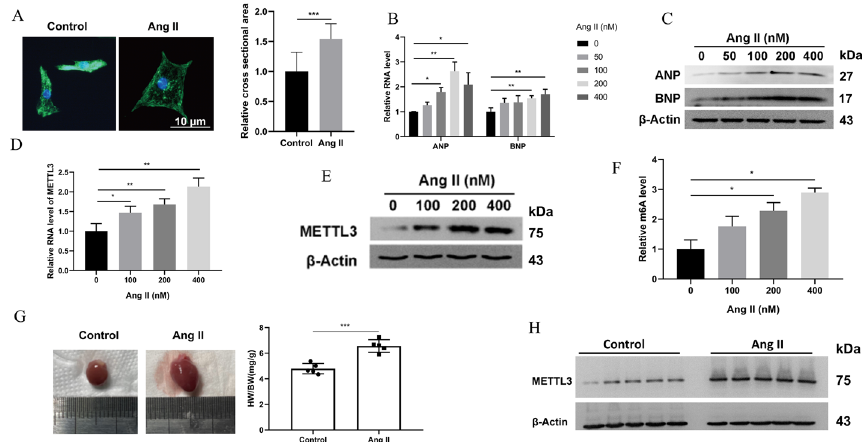
Fig. 1 Expression of METTL3 was upregulated in hypertrophic myocardium induced by Ang-II. A NRCMs were treated with Ang-II to induce hypertrophy. Representative immunohistochemistry images of NRCMs stained with α-actinin in green. The nucleus is stained in blue. Scale bars, 10 μm. The cell surface area was evaluated. n 3. B qRT-PCR detected the expression of hypertrophic biomarkers ANP and BNP in NRCMs = stimulated with Ang-II. n 3. C Western blot detected the expression of hypertrophic biomarkers ANP and = BNP in NRCMs stimulated with Ang-II. n 3. D qRT-PCR detected METTL3 expression in Ang-II-induced = myocardial hypertrophy in vitro. n 3. E Western blot detected the METTL3 expression in Ang-II-induced = myocardial hypertrophy in vitro. n 3. F Assay detected m6A modification of total RNA from Ang-II-induced = NRCMs. n 3. G Representative heart gross morphology. The HW:BW ratio was calculated by dividing heart = weight by body weight. n 5. H Western blot detected METTL3 expression in the myocardium of Ang-II = treated mice. n 5. * P < 0.05, ** P < 0.01, *** P < =